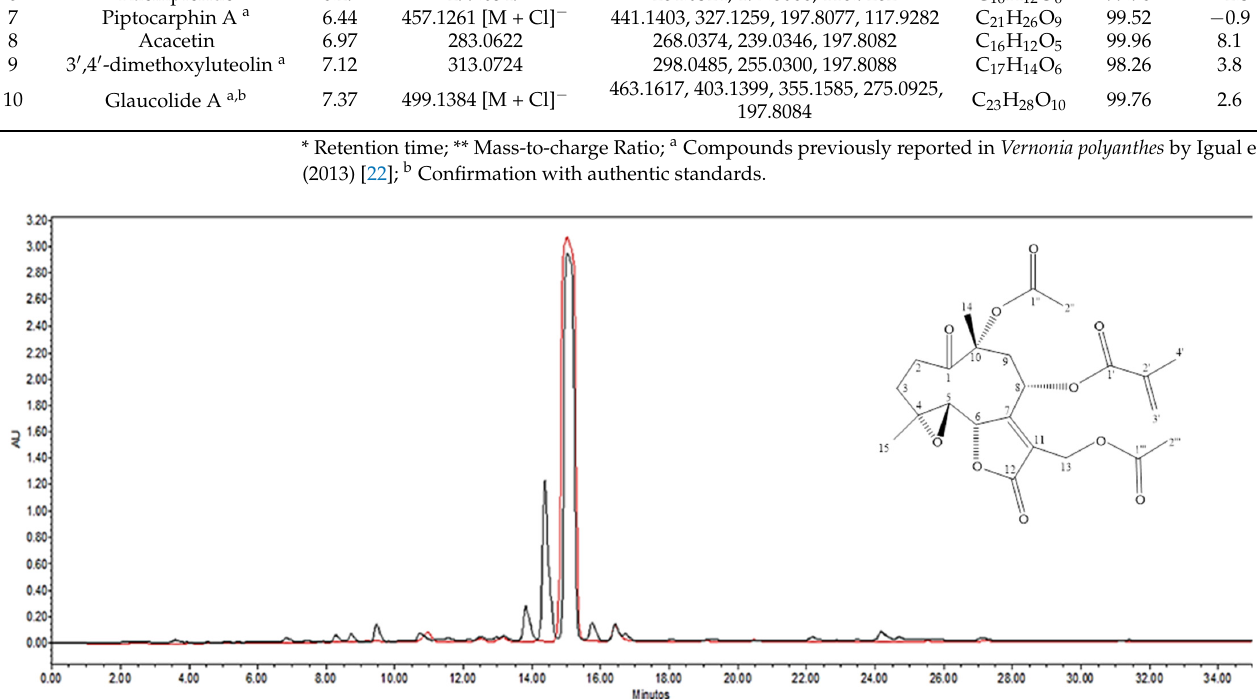
Figure 3. Evaluation of the cytotoxicity of V. polyanthes leaf rinse extract (Vp-LRE) and glaucolide A on RAW 264.7 cell line. Cell viability was evaluated via MTT assay and expressed as mean ± SD relative to untreated control (NT) (* p < 0.05 vs. NT).